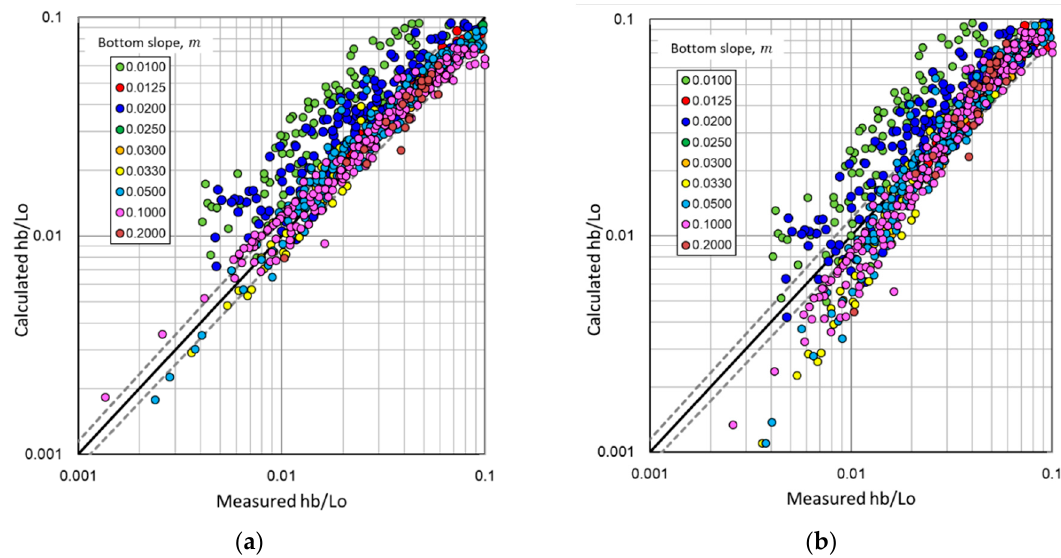
Figure 5. Comparison of wave breaking depth formulas with experimental data: ( a ) Rattanapitikon and Shibayama (2006); ( b ) Xie et al. (2019).